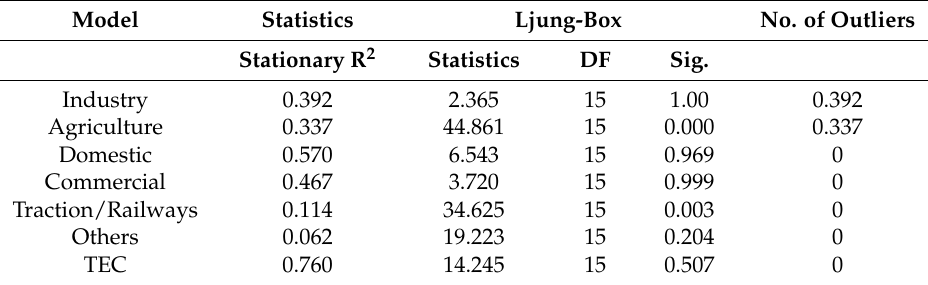
Table 10. Summary of Damped trend model.